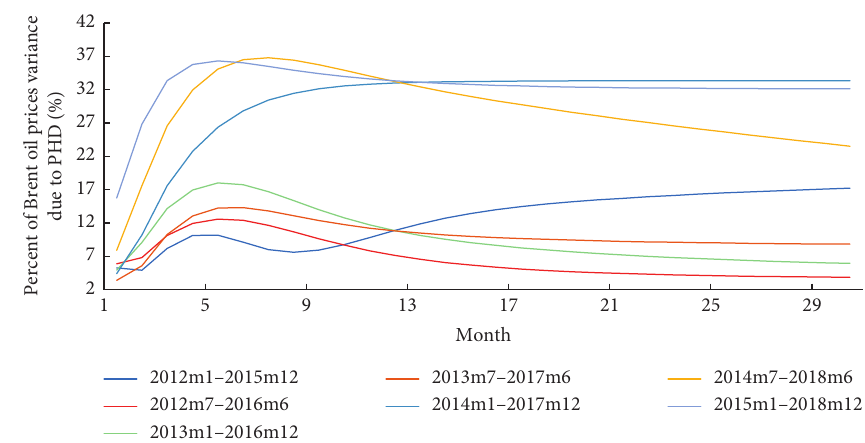
Figure 10: Percent of Brent oil prices variance due to PHD.